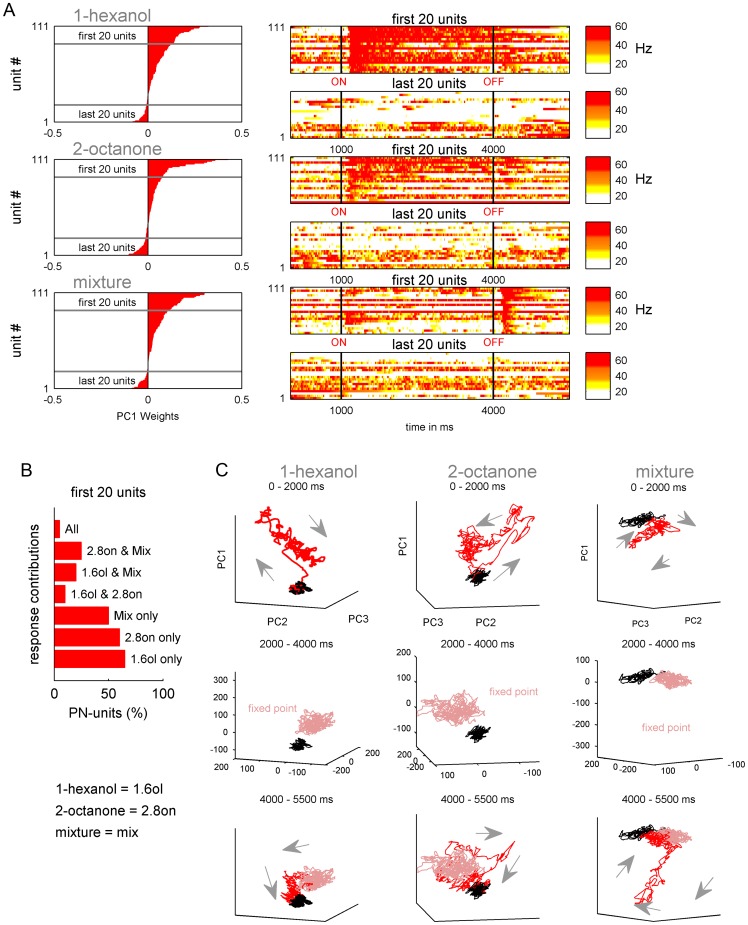
Principal Component Analysis (PCA) of the PN ensemble for each odor stimulus.(A) left: The weights of each unit (red bars; N = 111) on the first principal component (PC1) was used to order the units from positive (top) to negative weights (bottom). (A) right: the first (positive weights) and the last (negative weights) 20 units were used to illustrate the features extracted by PC1. Each line represent the false color coded IFR calculated out of the 10 repetitions per odor and unit. Stimulation is marked by black lines. PC1 contrasted odor sensitive (positive weights) and insensitive units (negative weights). (B) Most of the PN units were stimulus selective. For example; from the 20 first main contributing units of 1-hexanol, 65% respond to 1-hexanol only, 10% to 1-hexanol and 2-octanone, 20% to 1-hexanol and the mixture, and 5% to all stimuli. The same tendency was shown by the first 20 main contributing units of 2-octanone. (C) Projection of the transients of the first three PCs (PC1, PC2 and PC3). The column's separate the odors while the rows represent different time windows during stimulus presentation. Background activity of 1000 ms before odor onset is marked in black. The first row illustrates the first 1000 ms after odor onset (red), during which time there is a rapid divergence from background to form a transient. During the following 2000 ms (second row) odor evoked activity (pink) was clearly separated ‘fixed point’ from the spontaneous activity before odor onset (black). During the 1500 ms following the odor off set (third row, red) the activity returns to the background (black).